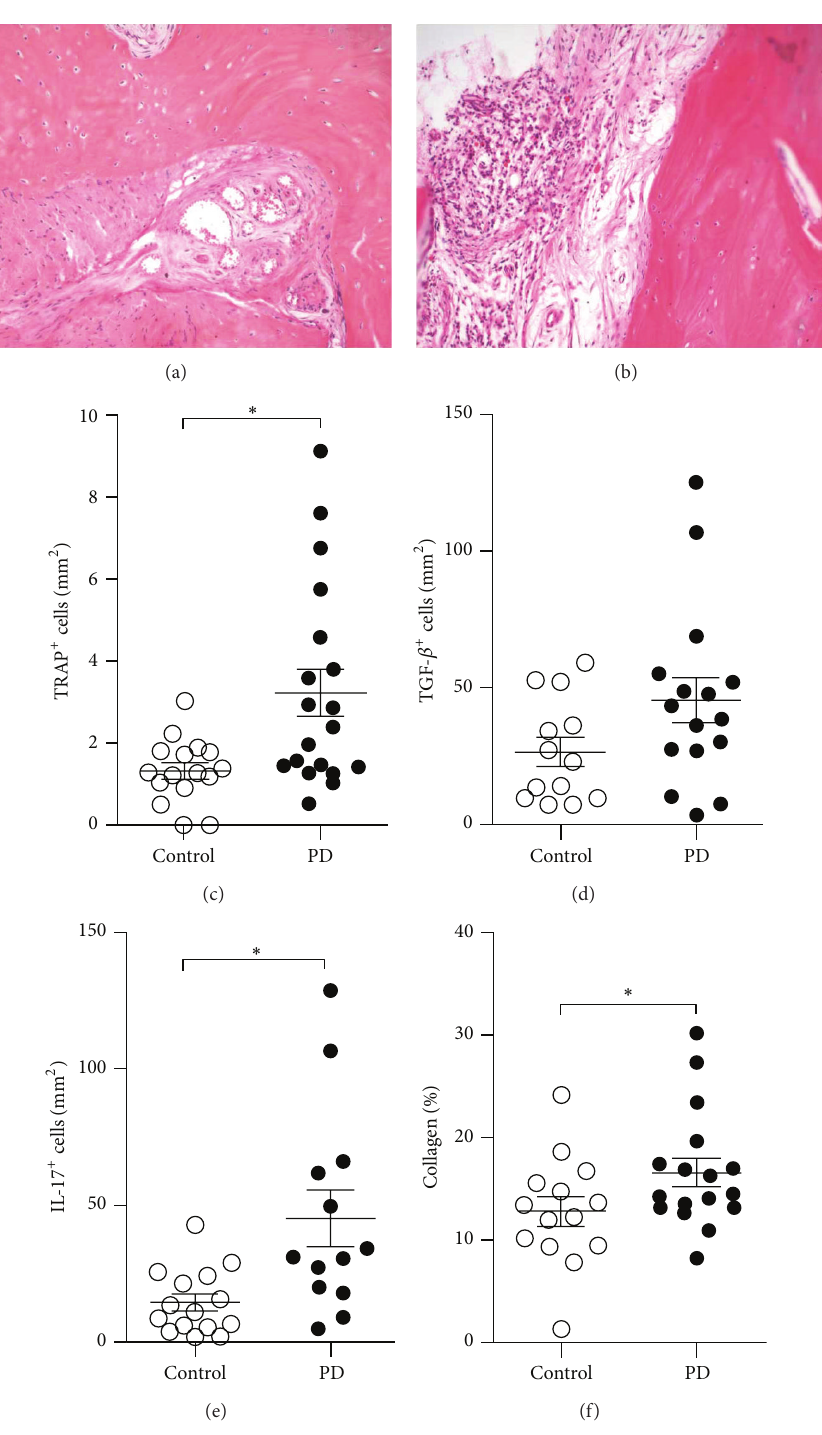
Figure 1: Histopathological analysis and cytokine and collagen production in tissues extracted from control and periodontal disease (PD) patients. Samples were fixed, decalcified, embedded in paraffin, and stained with Hematoxylin and Eosin (HE) or tartrate-resistant acid phosphatase (TRAP) staining protocol. (a) and (b) represent the HE slides from bone and adjacent tissue of control and PD group at 200x, respectively. (c) depicts the number of TRAP positive cells in the bone and adjacent tissue of control ( 𝑛 = 16 and PD ( 𝑛 = 19 ) subjects. Immunohistochemical staining is shown for TGF- 𝛽 (d) and IL-17 (e) for control ( 𝑛 = 13 ) and PD ( 𝑛 = 15 ) subjects. In (f), the percentage of Picrosirius stained areas for collagen quantitation in control and PD group, as described in Section 2. ∗ 𝑝 < 0.05